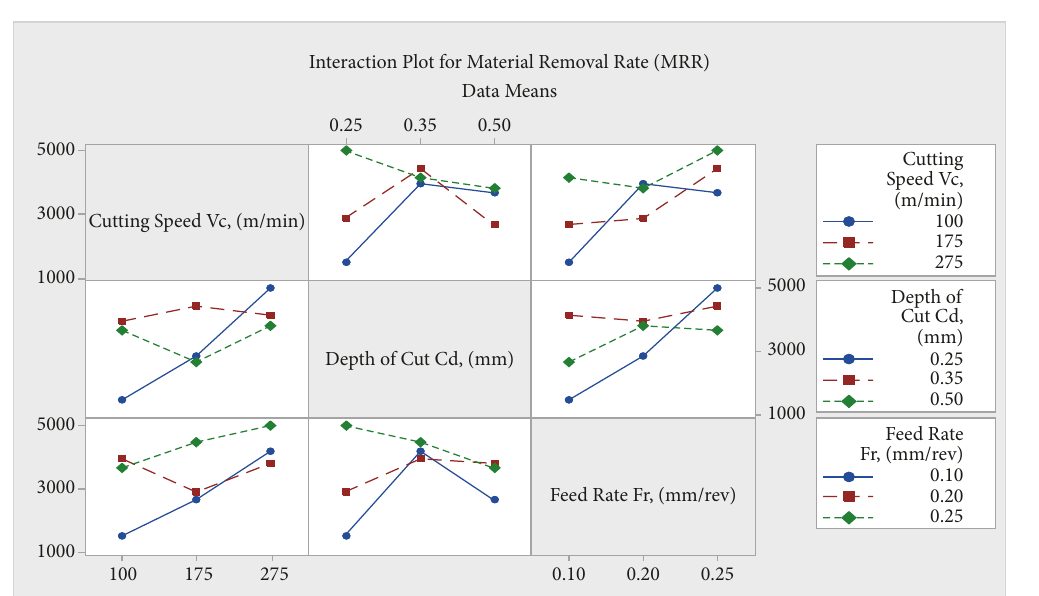
Figure 6: Interaction plots for MRR (mm 3 /min) with the corresponding process control